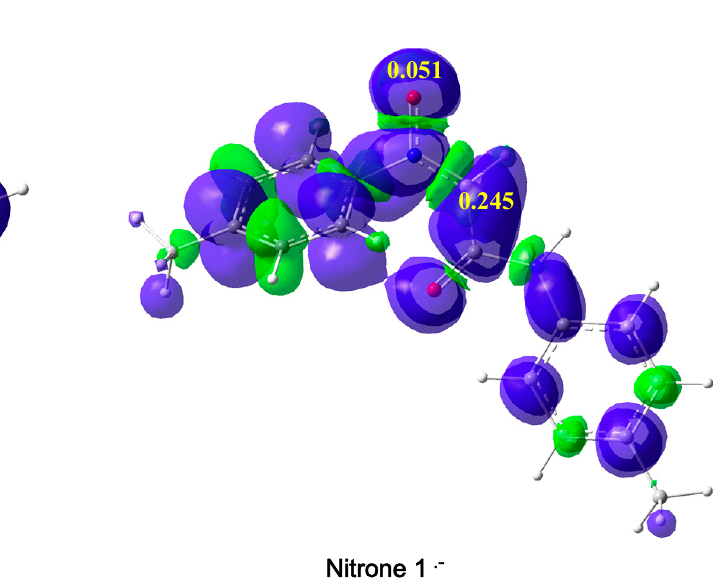
Figure 1. 3D maps of the ASD representation (isovalue = 0.006) of cations of nitrone 1 + and ethylene 2 + and anions of ethylene 2 − and nitrone 1 − together with the nucleophilic P − K indices (in red) and electrophilic P + K indices (in yellow), as well as the Parr function values of their reactive atoms.